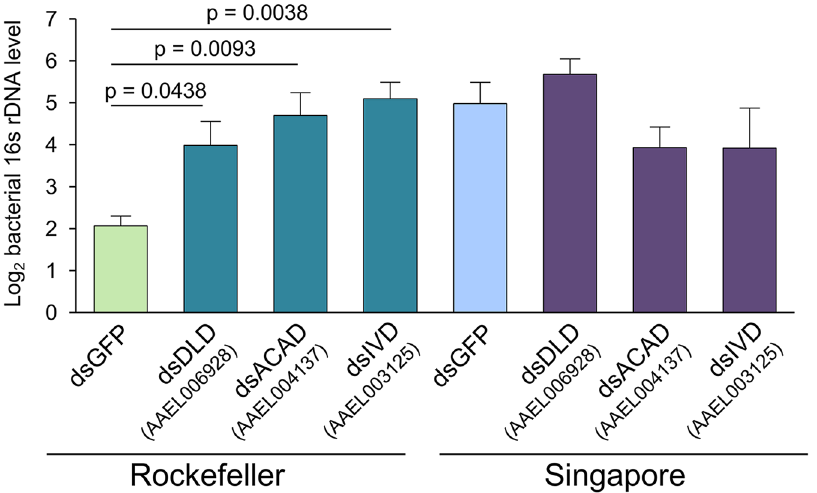
Fig 6. RNAi silencing of genes involved in Val-Leu-Ile degradation causes Rockefeller-specific increasesin relative bacterial 16S rDNA. We reared Rockefellerand Singaporemosquitoesin paralleland injectedthem at 3–5 days post-eclosion with 200ng of dsRNA targeting one of the three experimental genes or eGFP as a control. At two days post injection, we dissected two pools of eight midguts for each strain/ treatment combination. This entire experiment was repeatedthree independenttimes. We extracted DNA from each midgut pool and performed qPCR to quantify levels of the bacterial16S rDNA gene and A . aegypti S7 reference gene. We averaged delta Ct values from pools from the same biologicalreplicatebefore analysisto prevent pseudoreplication, and Y-axis values are averageinversedelta CT values, i.e. -1 * (CT 16S –CT S7 ) for each treatment. BecauseCT values are Log 2 , a difference of 1 on the y-axis correspondsto a 2-fold changein 16S DNA abundance. Error bars representone standard error. Raw delta CT values were analyzedin R by ANOVA followedby a Dunnett’stest using the followingmodel: Y ijk = μ + strain j + treatment k + strain j * treatment k . We detected a significantinteractionbetweenstrain and treatment (p = 0.0044), and using a Dunnett’s test found that silencingall three genes caused a significantincreasein 16S rRNA gene levels relative to Rock GFP-injected controls. No significanteffects of silencingwere detected in Sing females. DLD = dihydrolipoamide dehydrogenase, ACAD = acyl-CoA dehydrogenase, IVD = isovaleryl-CoA